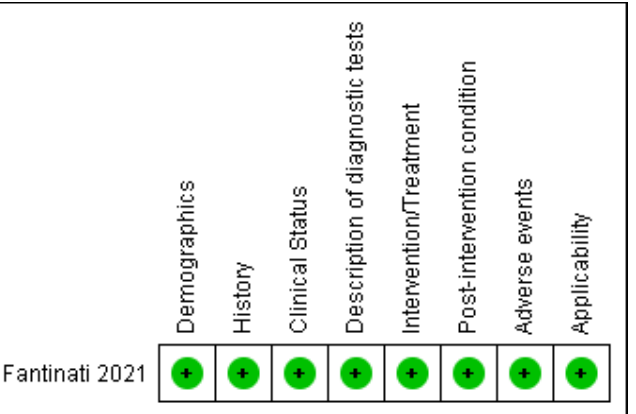
Figure 7. Reporting guidelines summary: review authors’ judgements about reporting on each criterion as percentage across all included studies.